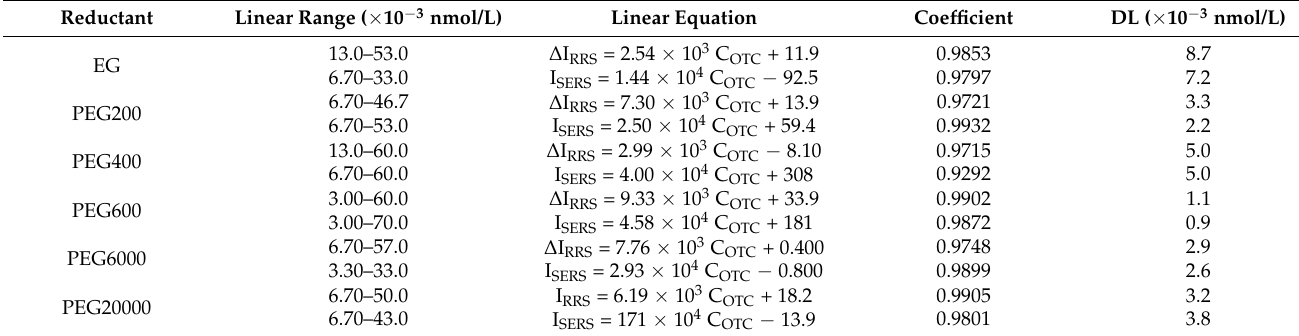
Table 1. RRS/SERS analysis features of HAuCl 4 -glycol (GC)/PEG-Apt-DdBd-OTC system.